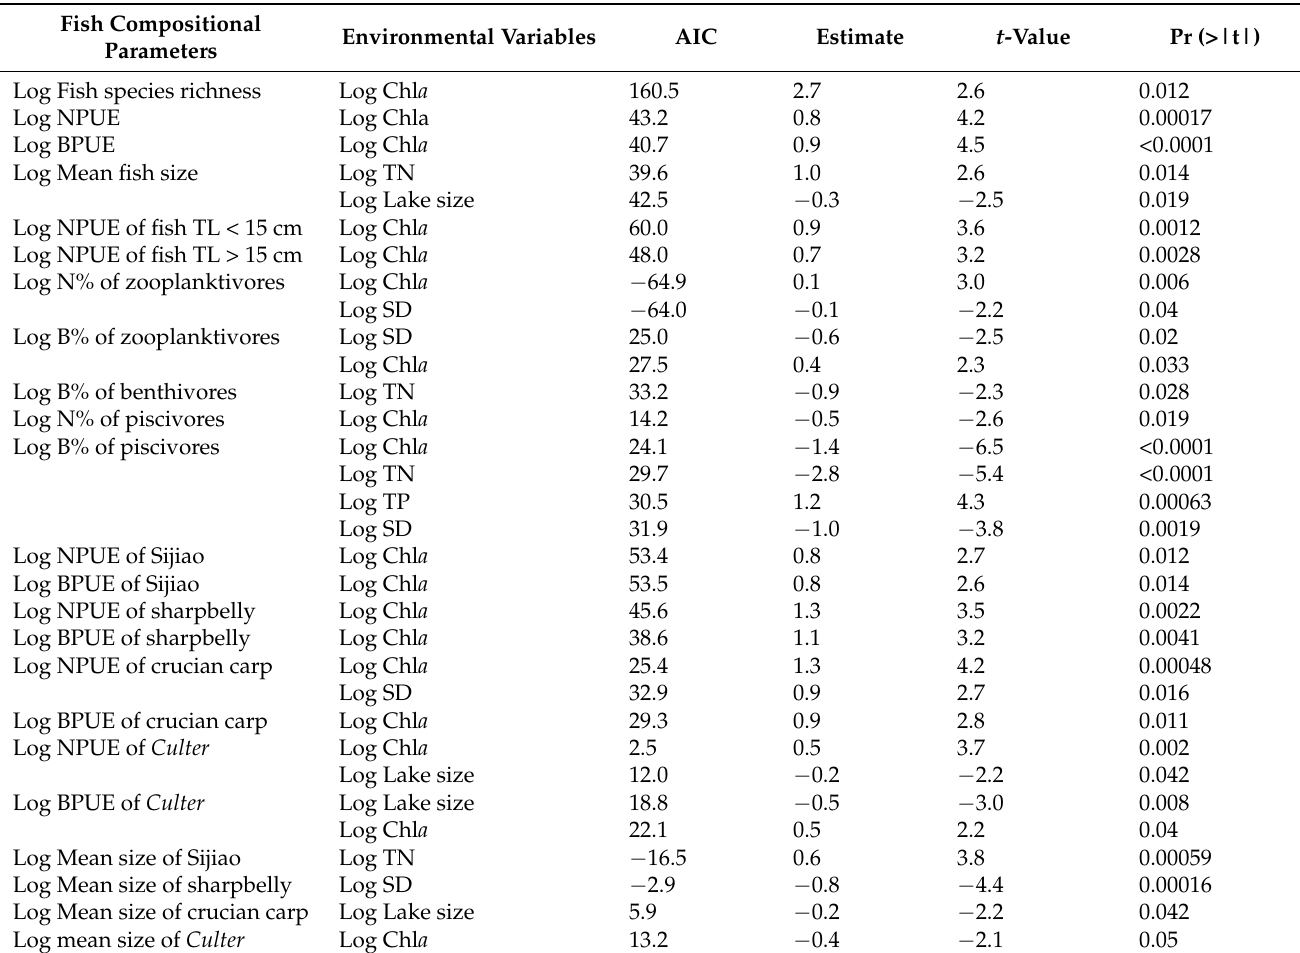
Table 2. Results of the multiple regressions using a generalized linear model (GLM) to select the significant explanatory environmental variables for fish compositional data. Environmental variables: chlorophyll a concentration in phytoplankton (Chl a, µ g L − 1 ), mean depth (m), total nitrogen in the water (TN, mg L − 1 ), lake surface size (km 2 ), Secchi depth (SD, m), and total phosphorus in the water (TP, µ g L − 1 ). AIC, Akaike Information Criterion. Fish community traits: NPUE,